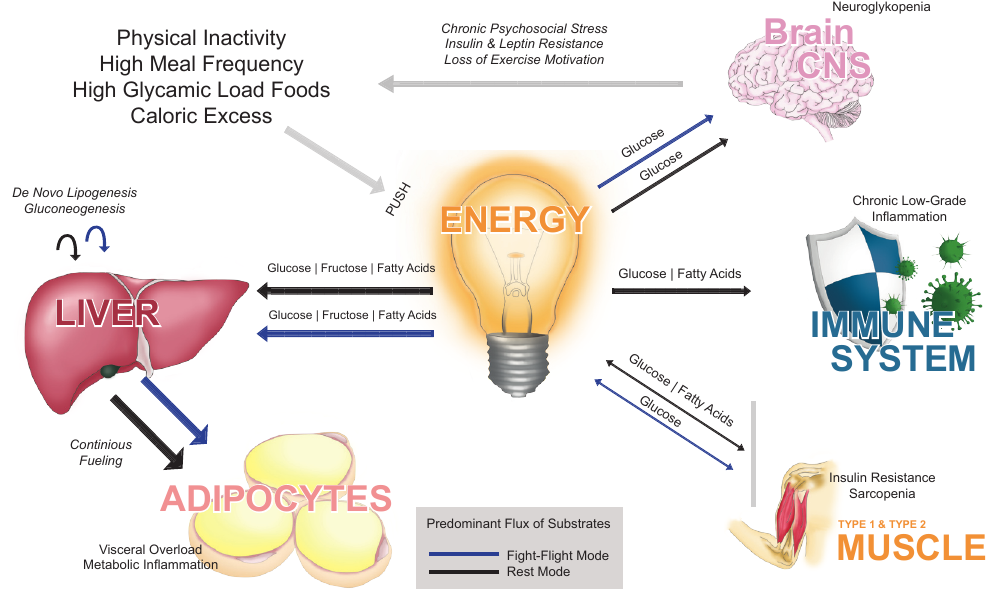
Figure 2. Metabolic inflexibility in the sedentary lifestyle. The “brain pull” (energy allocation from storage organs to the central nervous system) is compromised by “pushing” energy-rich nutrients into the metabolic system continuously. As a consequence, the foraging and starvation modes are both permanently unattended, which leads to a constant fueling of adipocytes, and in the long run to lipotoxicity, sarcopenia, low-grade inflammation and all associated metabolic diseases.